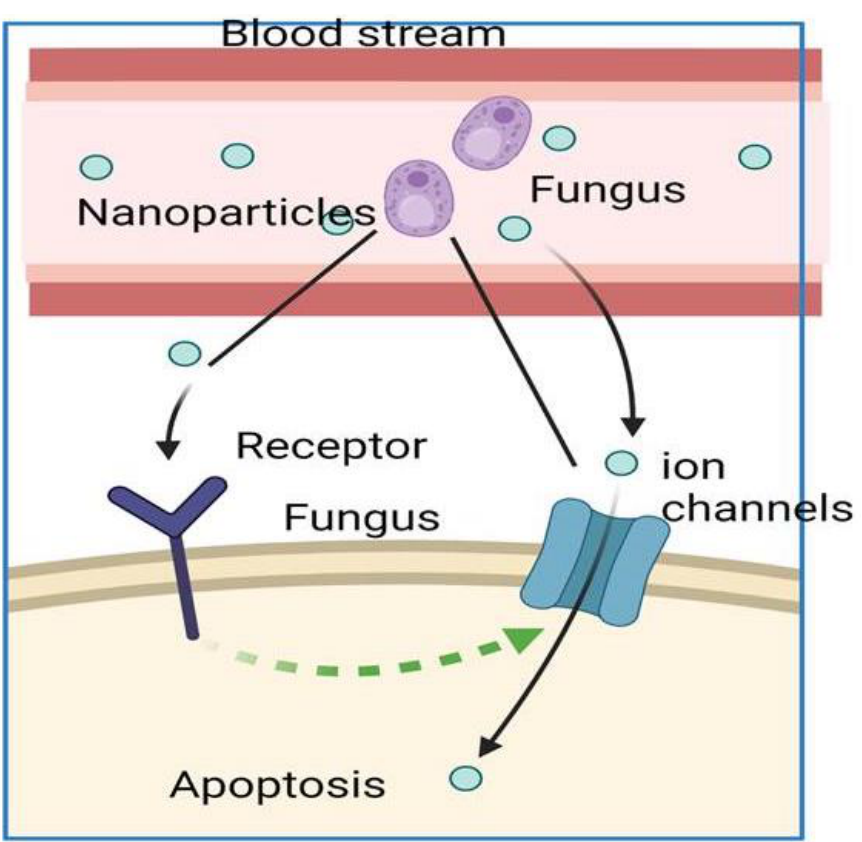
Figure 2. Fungi penetrating the blood-brain barrier and circulating in the bloodstream. Fungal propagation involves spore inoculation, escaping phagocytosis by macrophages and neutrophils, hyphae germination, growth by taking advantage of the condition of the host attaching to the endothelium using receptors, and damaging the endothelium and eventually causes impairs ion channels and induces apoptosis. This process results in tissue necrosis, thrombus formation, or hemorrhage.